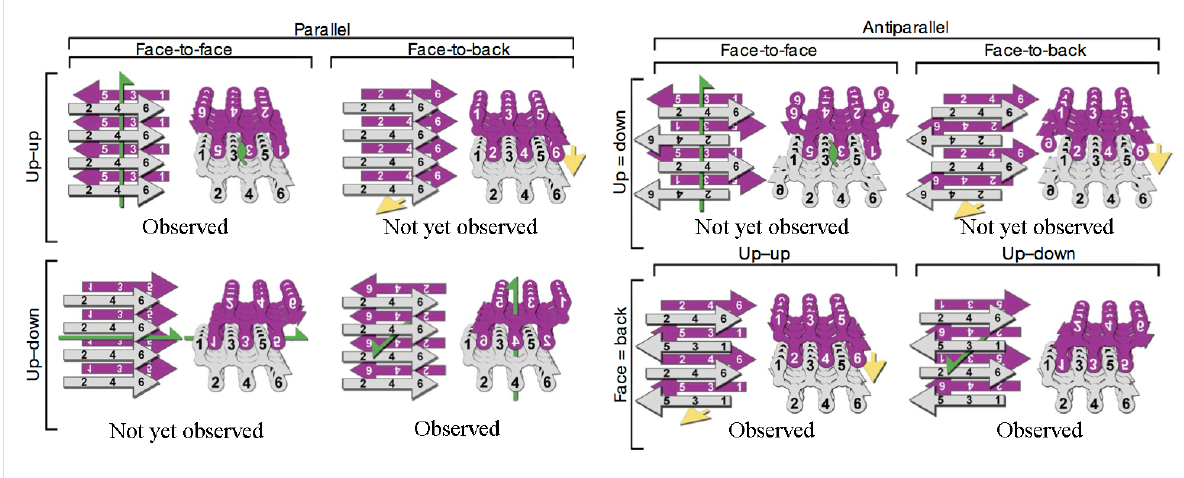
Figure 13: Possible options for the arrangement of β -sheets in a cross- β motif. Two identical sheets can be classified by the orientation of their faces (either “face-to-face” or “face-to- back”), the orientation of their strands (with both sheets having the same edge of the strand “up”, or one “up” and the other “down”), and whether the strands within the sheets are parallel or antiparallel. Both side views (left) and top views (right) show which of the six residues of the segment point into the zipper and which point outward. Green arrows show two-fold screw axes, and yellow arrows show translational symmetry. Below each class are listed protein segments that belong to that class. Reprinted by permission from Macmillan Publishers Ltd: Nature [37], copyright 2007.